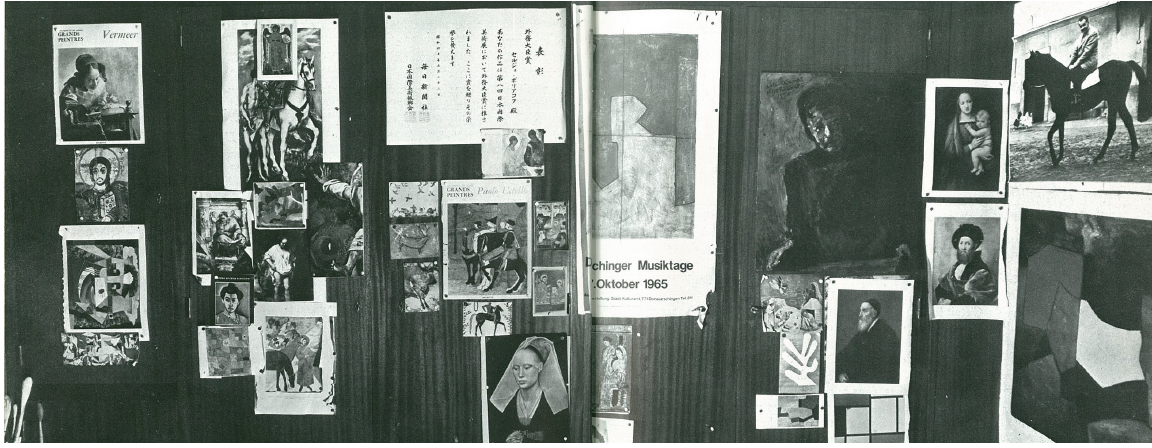
FIGURE 4 | The Mnemosyne on the wall of Poliakoff’s